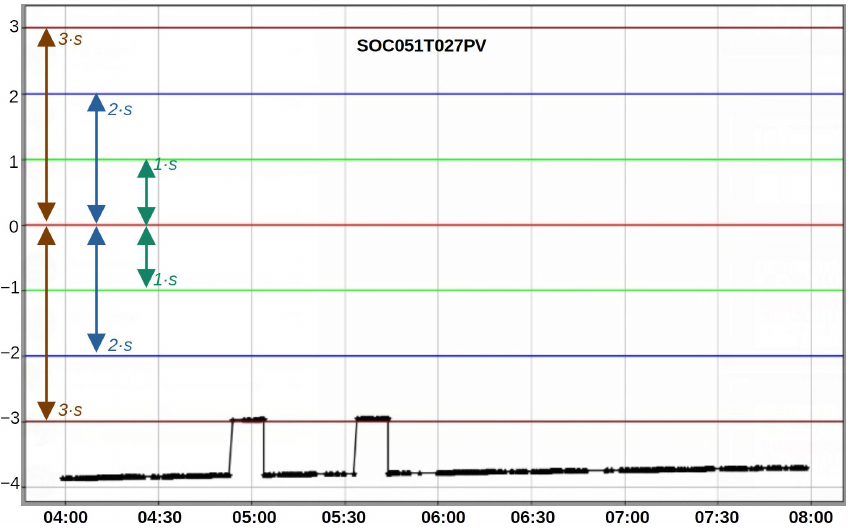
Figure 9. Trend of the variable SOC051T027PV (one of the two temperature sensors of cylinder A6 in the Cylinders subsystem) during the time window #1 (between 03:57 and